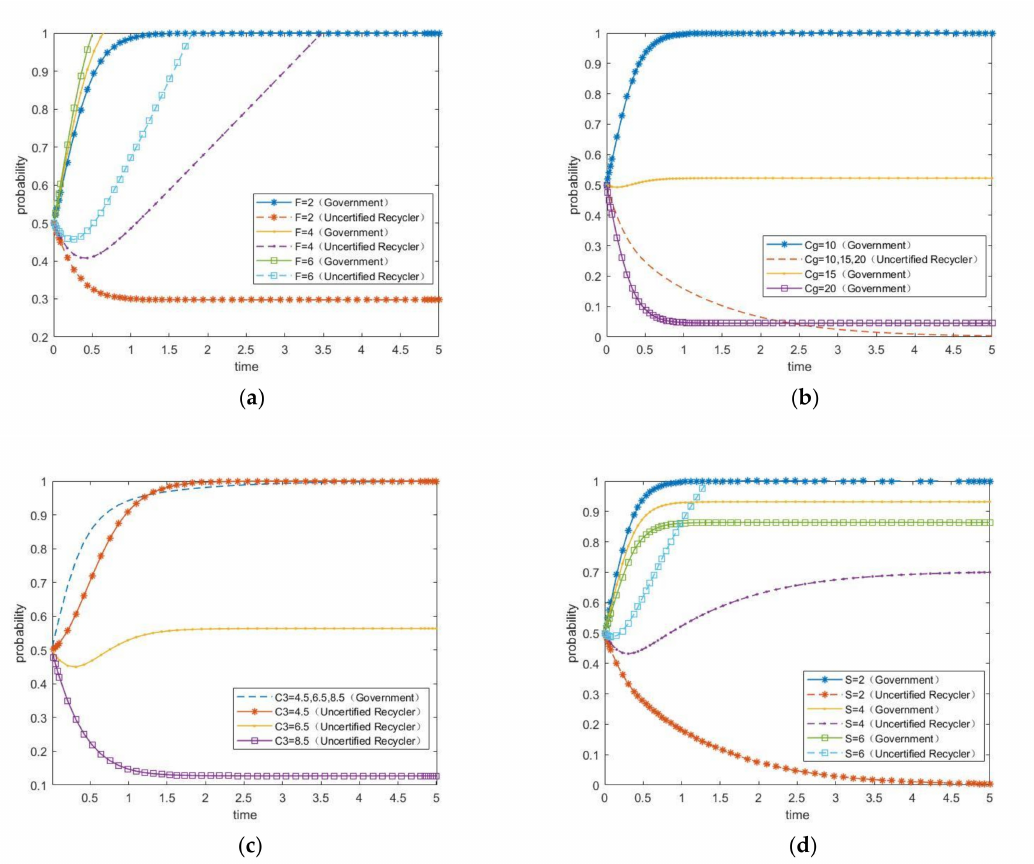
Figure 3. The impacts of the parameters on the evolution of the two participants’ behaviors. ( a ) Penalty; ( b ) supervision cost; ( c ) additional investment cost; ( d )